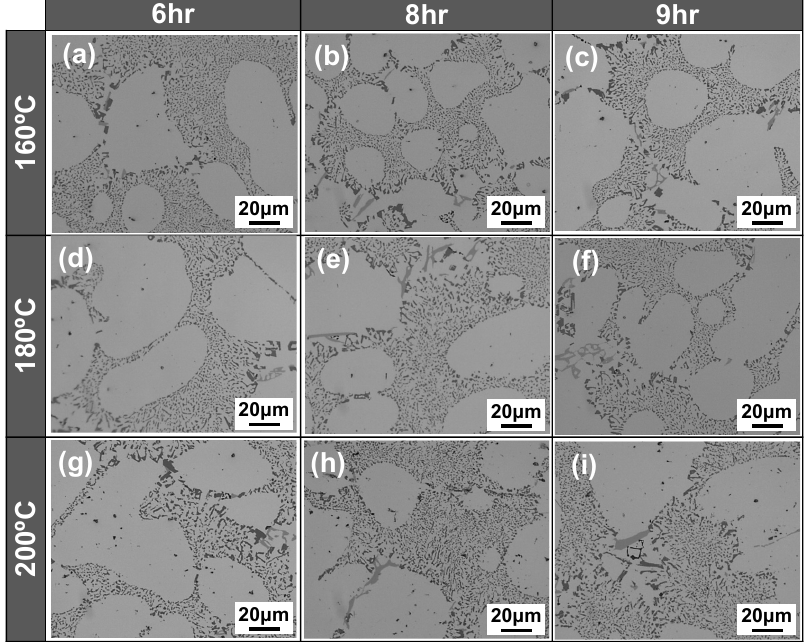
Figure 4. ( a – i ) Microstructures of the CPC A356 specimen under various T5 heat treatment conditions.